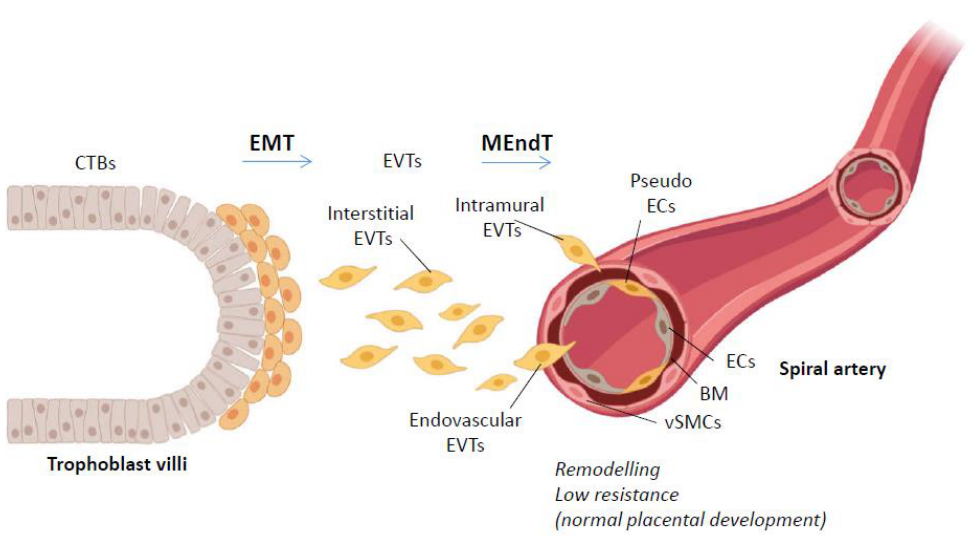
Figure 3. Epithelial-to-mesenchymal transition (EMT) and mesenchymal-to-endothelial transition (MEndT) in human placental development at the fetal–maternal interface. When CTBs differentiate in EVTs, they undergo EMT and invade the decidua. E-cadherin expression is decreased and EMT transcription factors are upregulated. Matrix metalloproteases (MMPs) and lysyl oxidases also need to be activated. Then, the EVTs (both endovascular and intramural) undergo MEndT during the arterial remodelling of the maternal spiral artery. The expression profile of these pseudo-ECs is characterized by upregulation of the vascular markers vascular endothelial (VE)-cadherin, platelet endothelial adhesion molecule-1 (PECAM-1; CD31), vascular cell adhesion molecule-1 (VCAM-1), α4 integrin, and αvβ3 integrin.